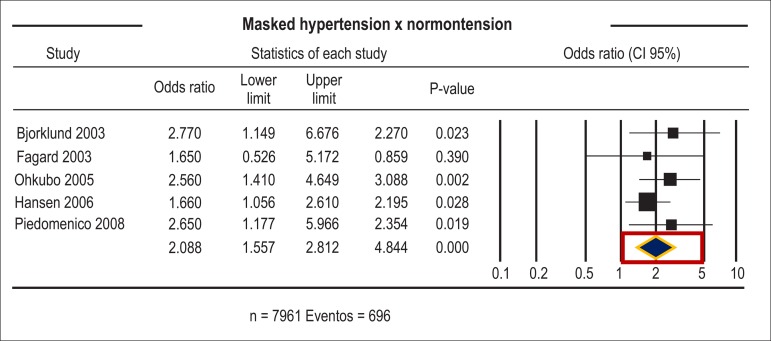
Odds ratio of patients with masked hypertension compared with
normotensive patients.34